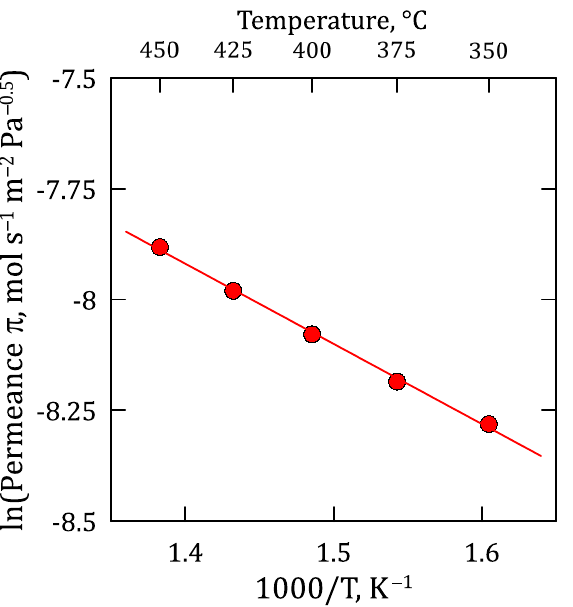
Figure 7. Arrhenius ‐ type plot for evaluating the temperature influence on H 2 permeation. Figure 7. Arrhenius-type plot for evaluating the temperature influence on H